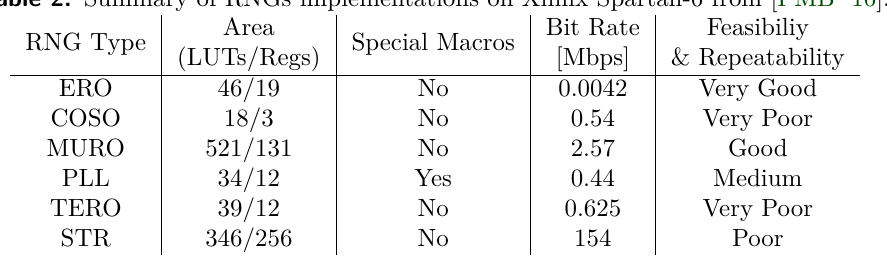
Table 2: Summary of RNGs implementations on Xilinx Spartan-6 from [PMB +